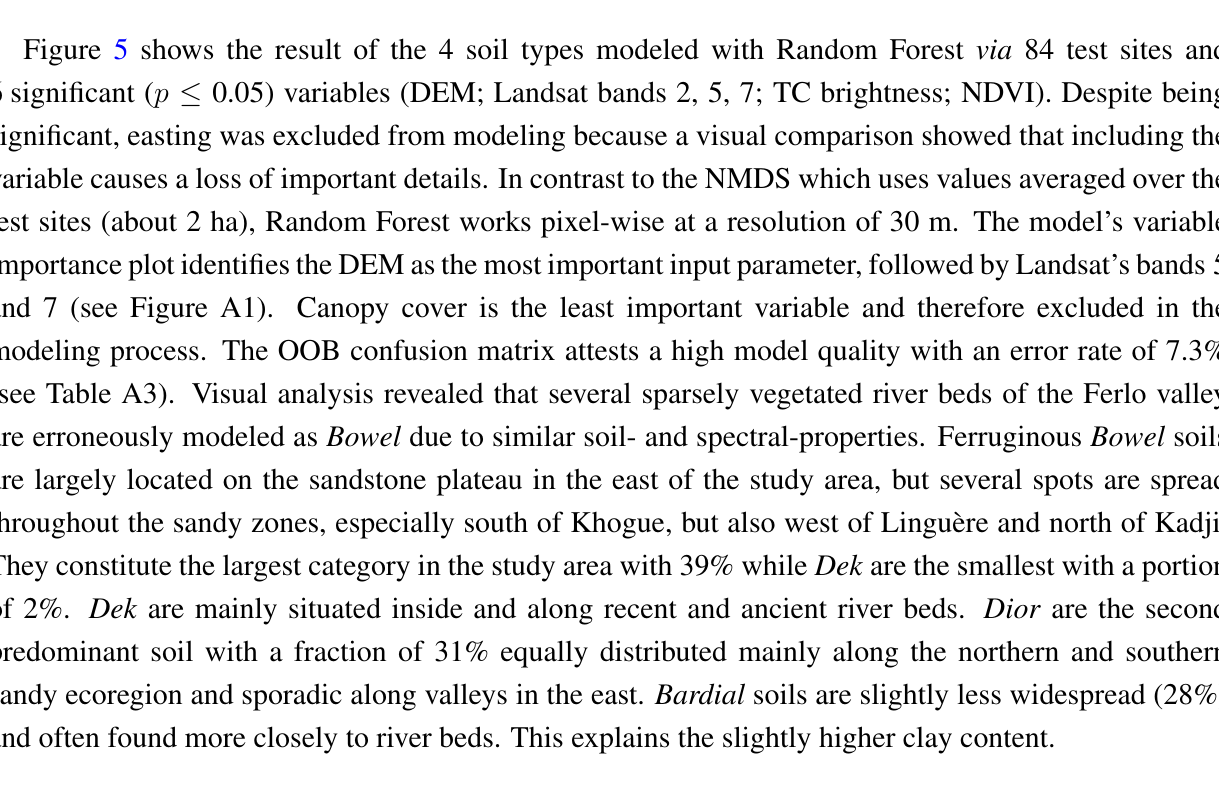
Figure 5. Modeled soil types in the Ferlo around Linguère. The legend shows the soil names in Wolof. For the corresponding scientific names, see Table 1. The area represents the square in Figure